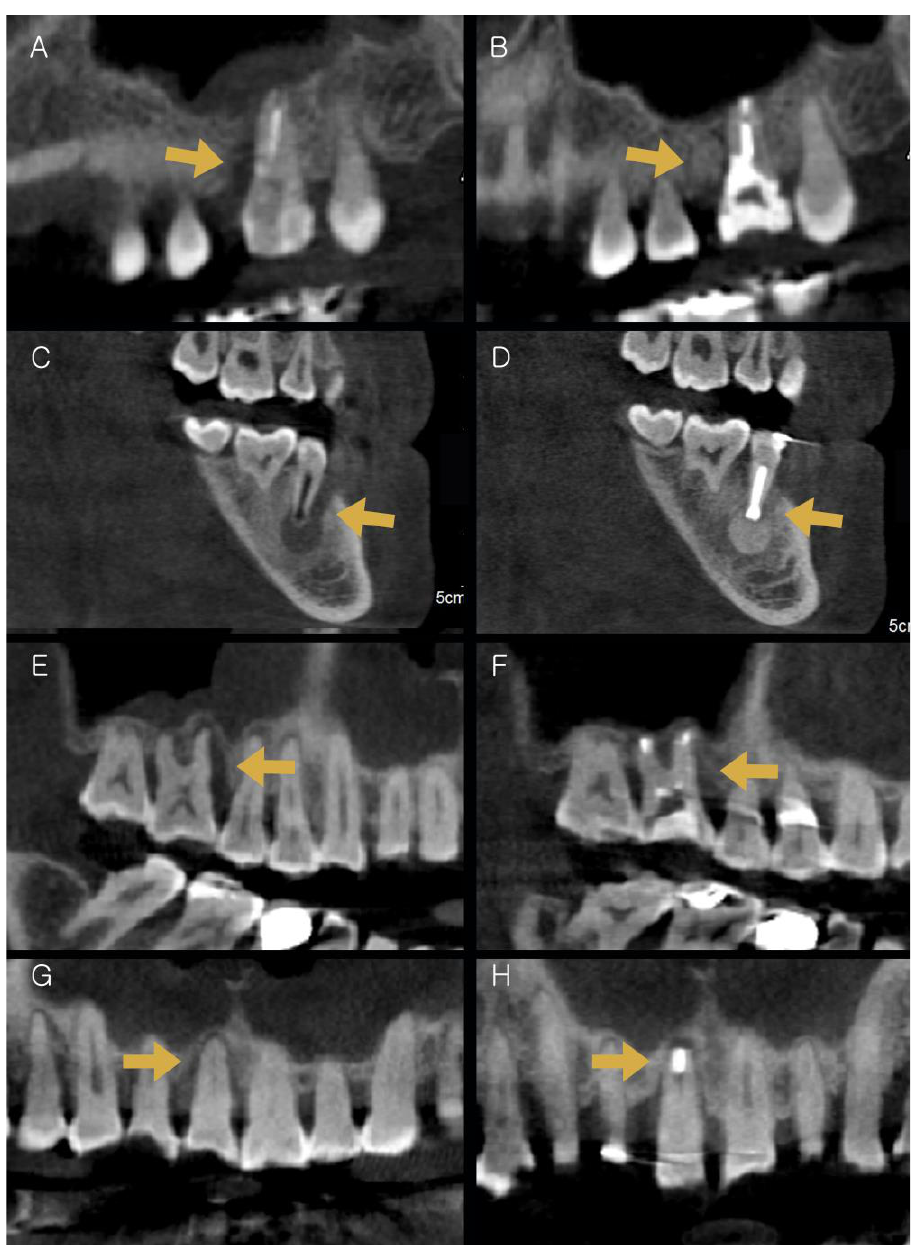
Figure 4. Images of CBCT between before and after IR. ( A , C , E , G ) CBCT images before IR; ( B , D , F , H ) CBCT images after IR (Arrow: bone healing area); IR: intentional replantation, CBCT: Cone–Beam Computed Tomography. Table 4. Changes in bone height before and after IR.